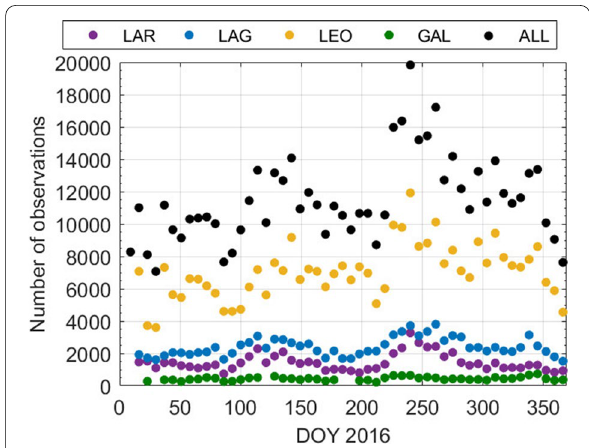
Fig. 2 SLR observations to different types of satellites (LAR, LAG, LEO, GAL) and sum of all (ALL) in 7-day